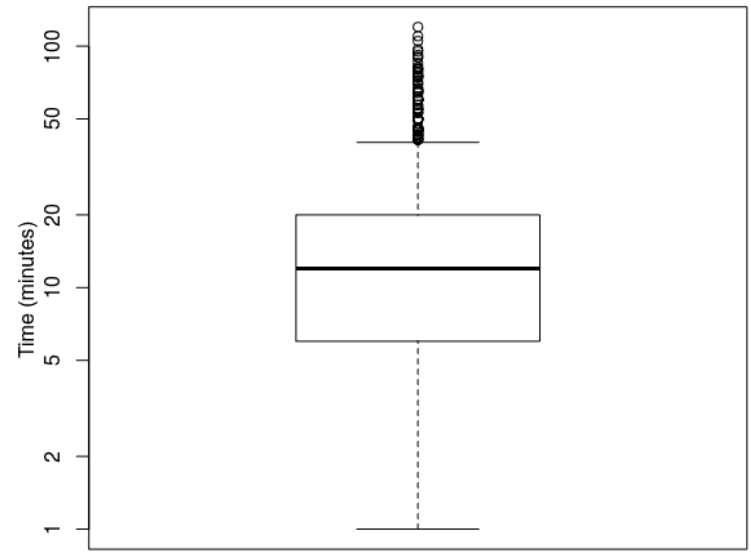
Figure 6. Home–school travel time.